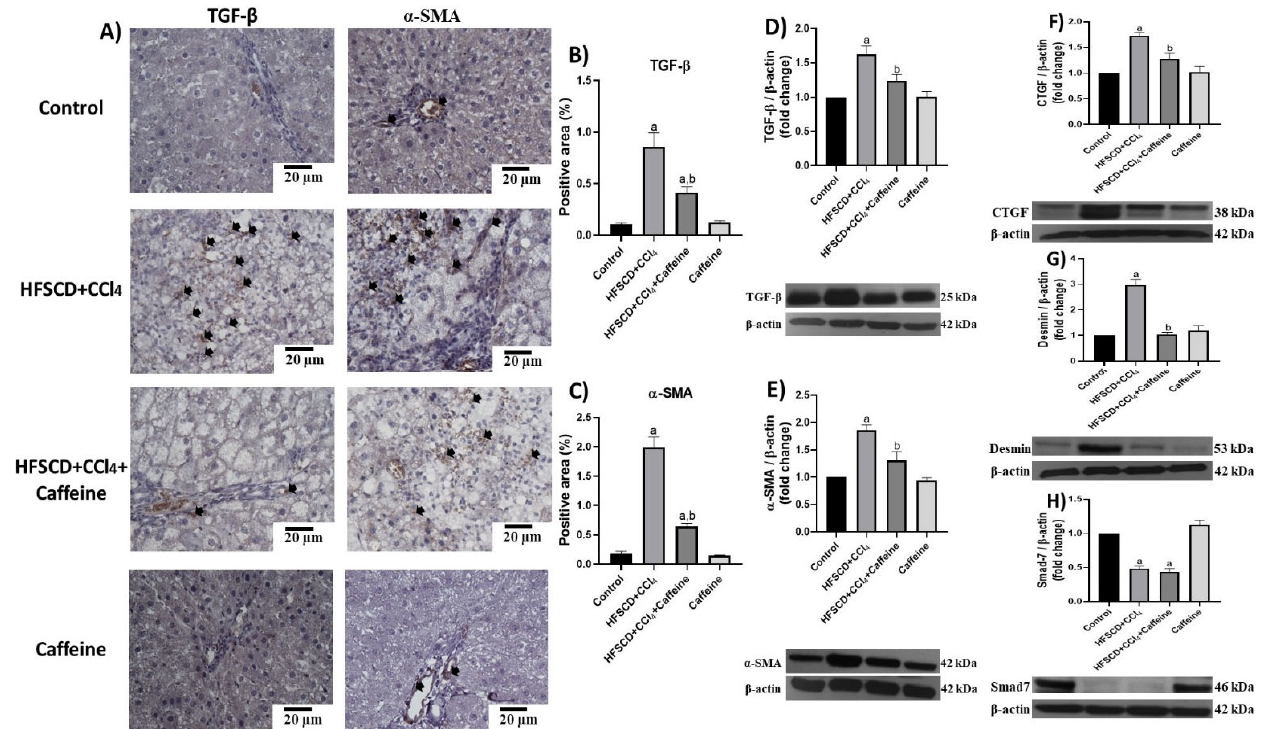
Figure 8. Caffeine maintains basal levels of TGF ‐β , α‐ SMA, and profibrogenic mediators in hepatic tissue from the NASH model. ( A ) Representative IHC images of TGF ‐β and α‐ SMA in the control, HFSCD+CCl 4 , HFSCD+CCl 4 +caffeine, and caffeine groups. Scale bar = 20 μ m. Positive areas for TGF ‐β ( B ) and α‐ SMA ( C ) are shown in the histogram (n = 4). Protein levels of TGF ‐β ( D ), α‐ SMA ( E ), CTGF ( F ), desmin ( G ), and Smad7 ( H ) were detected using western blot analysis (n = 3); β‐ actin was used as a loading control. Values are shown as a fold increment in optical density normalized to control group values (control = 1). Bars represent the mean ± SEM. (a) p < 0.05 compared with the control group; (b) p < 0.05 compared with the HFSCD+CCl 4 group.